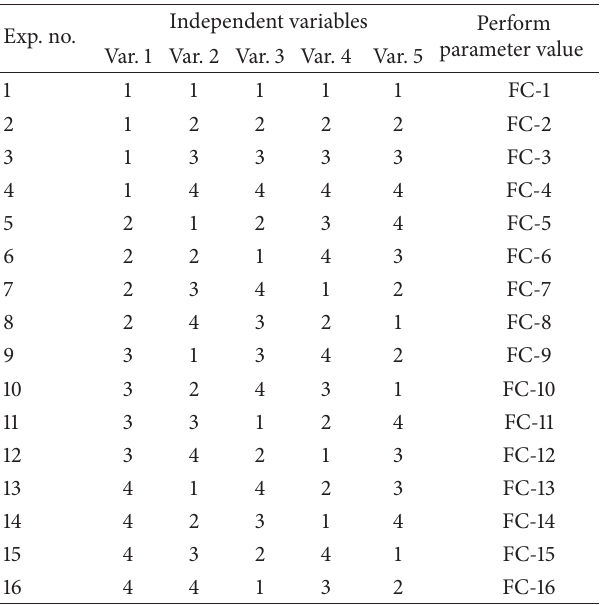
orthogonal array. 16